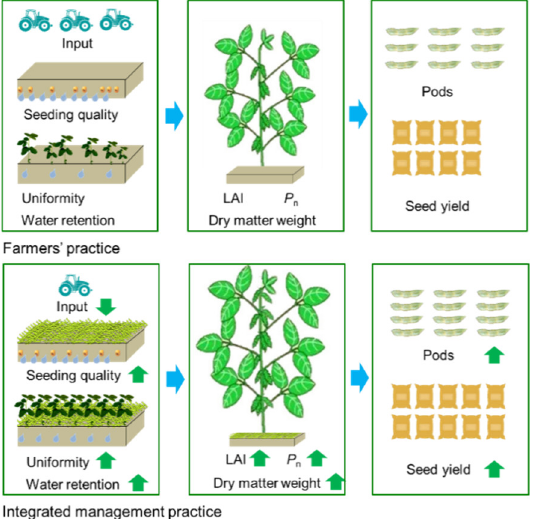
Figure 10. A contrastive diagram for the two seeding management practices in soybean productivity. LAI, leaf area index. P n , photosynthetic rate.